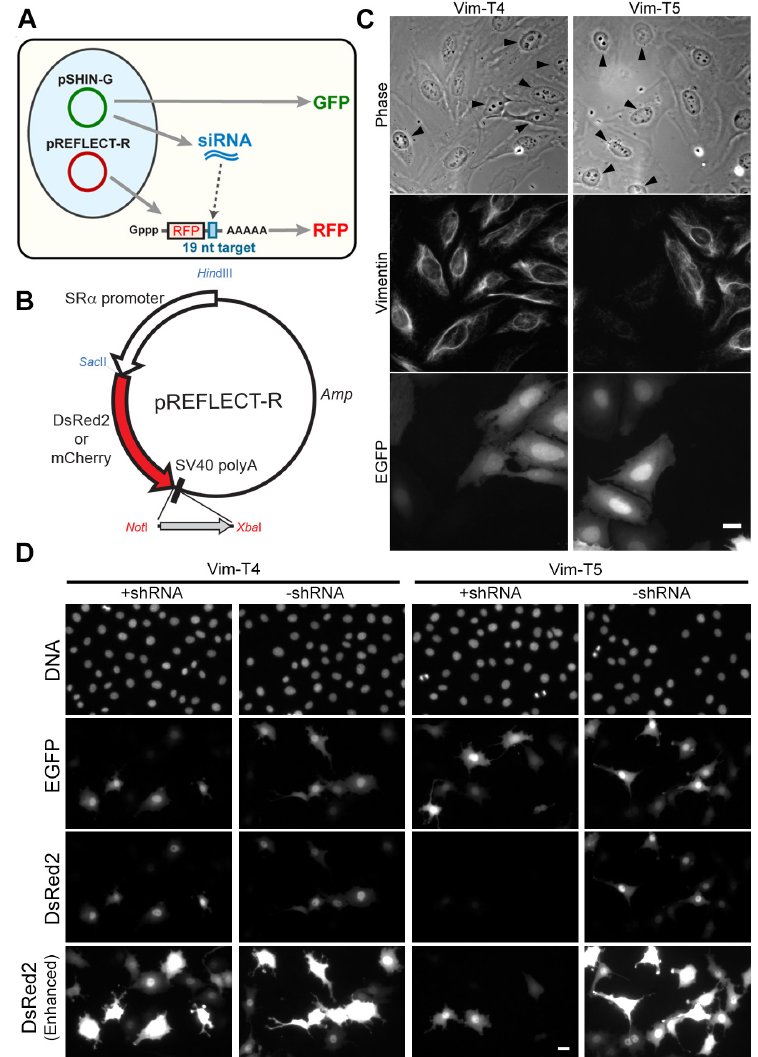
Figure 1. Dual fluorescence ratiometry assay. ( A ) Experimental design. Two plasmids (pSHIN-G and pREFLECT-R) are used. The plasmid pSHIN-G expresses shRNA and GFP simultaneously, whereas pREFLECT-R expresses a red fluorescent protein (RFP), DsRed2 or mCherry. The 3 ′ -UTR of the RFP mRNA contains a 19-nt sequence target of siRNA to be tested. If siRNA, which is generated from shRNA, is effective, RFP expression is suppressed, resulting in reduction of red fluorescence. ( B ) The map of pREFLECT-R. RFP expression is driven under the SR α promoter. A 19-nt target sequence is inserted between Not I and Xba I sites. ( C ) Immunofluorescence of HeLa cells transfected with pSHIN-G-Vim-T4 and -T5. Phase contrast, vimentin-staining and EGFP images are shown. Arrowheads in the phase contrast images indicate transfected cells as shown by EGFP expression. The Vim-T5 shRNA expression suppressed vimentin significantly, while Vim-T4 did not show the RNAi effect. Bar, 20 µm. ( D ) Fluorescence images of co-transfection of pSHIN-G and pREFLECT-R(DsR) derivatives. Rat2 cells were transfected with pSHIN-G-Vim-T4 plus pREFLECT-R(DsR)-Vim-T4 (Vim-T4; +shRNA), pSHIN-G empty plasmid vector plus pREFLECT- R(DsR)-Vim-T4 (Vim-T4; -shRNA), pSHIN-G-Vim-T5 plus pREFLECT-R(DsR)-Vim-T5 (Vim-T5; +shRNA) or pSHIN-G empty plasmid vector plus pREFLECT-R(DsR)-Vim-T5 (Vim-T5; -shRNA). Two days after transfection, cells were fixed and DNA-stained with Hoechst33342. DNA, EGFP and DsRed2 fluorescence images are shown. The red fluorescence was not changed by shRNA expression of the Vim-T4 shRNA, whereas the Vim-T5 shRNA reduced red fluorescence significantly. Bar, 20